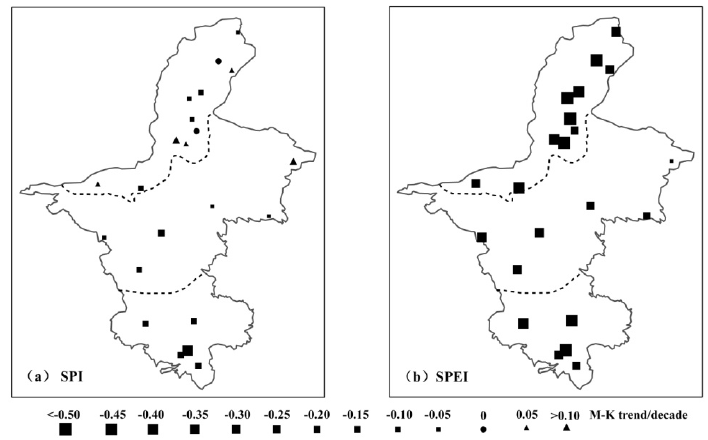
Figure 4. M–K trends of annual SPI/SPEI series at the 12-month time scale for 22 stations during years 1972–2011 in Ningxia. ( a ) SPI, ( b )